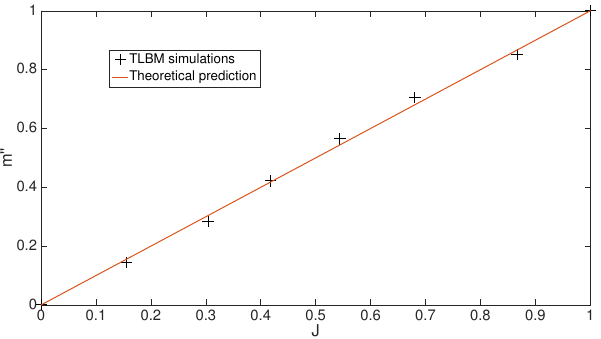
Figure 9. Mass flux under different heating conditions: the black cross markers are the simulations, and the red line is the theoretical prediction by Equation (36), both J and m (cid:48)(cid:48) are normalized. The mass flux discussed above corresponds to an ensemble property of the evaporating pore.